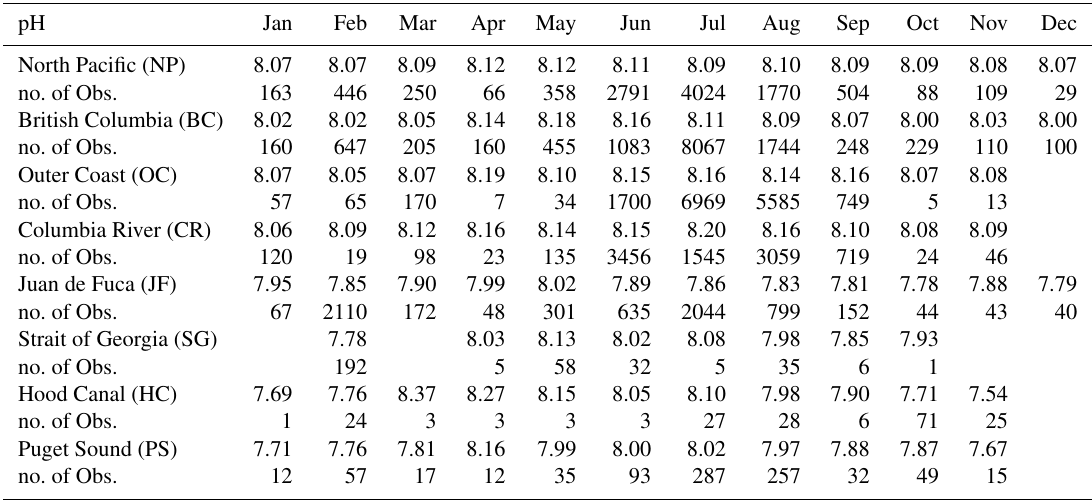
Table B6. Average monthly pH seasonal cycles for the eight unique regions. The total number of observations (no. of Obs.) contributing to the monthly average estimate is